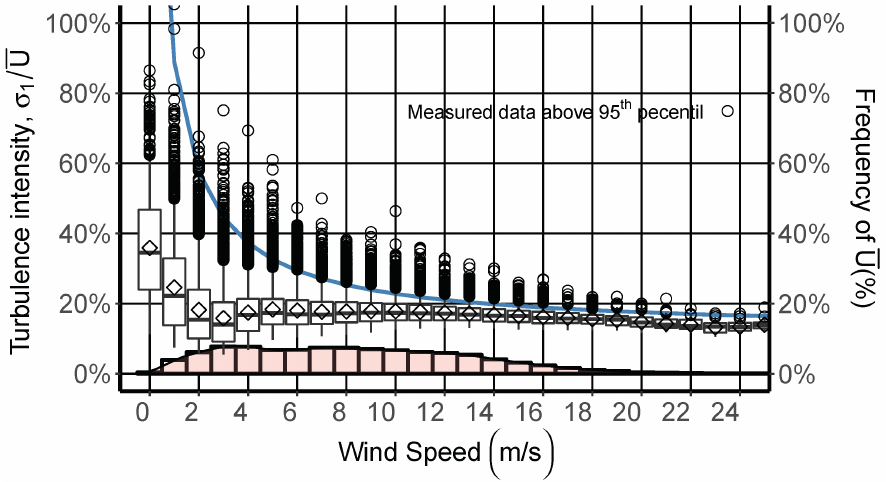
Figure 9. Box plot with NTM using I 15 = 0.18 (blue line) for data measured at 40 m high. The diamond shape located inside the box shows the average turbulence intensity value, and the histogram represents the wind speed frequency